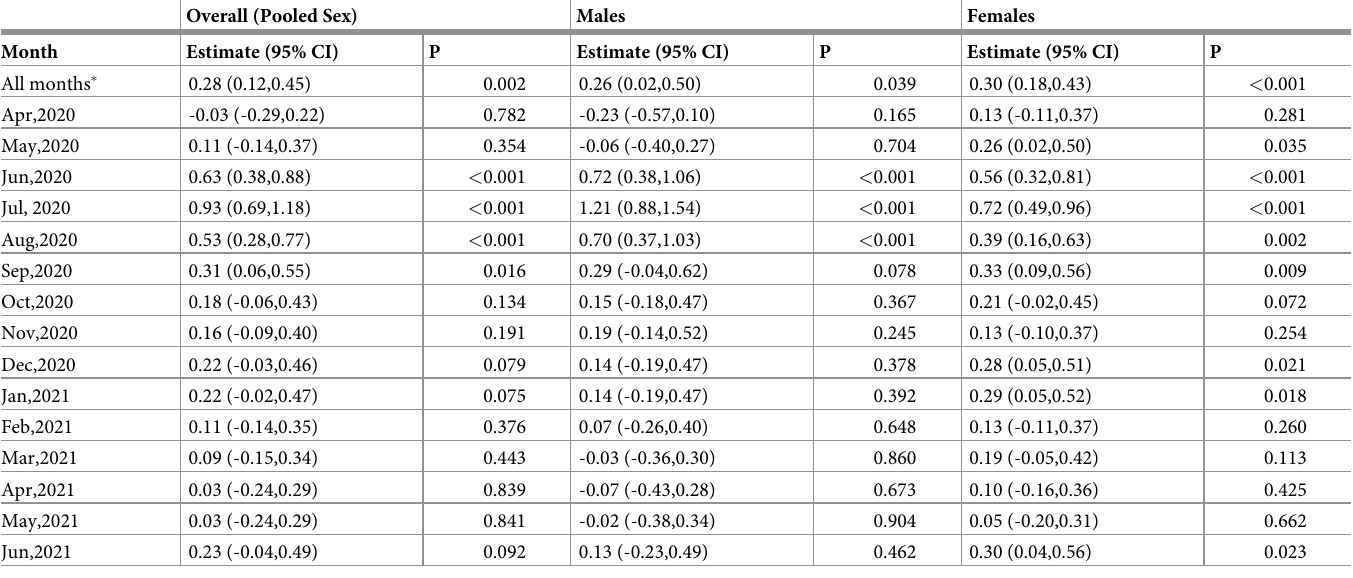
Table 3. Adjusted estimated differences in country-level monthly suicide rates per 100,000 population during COVID-19 pandemic compared to same months in the pre-pandemic periods.